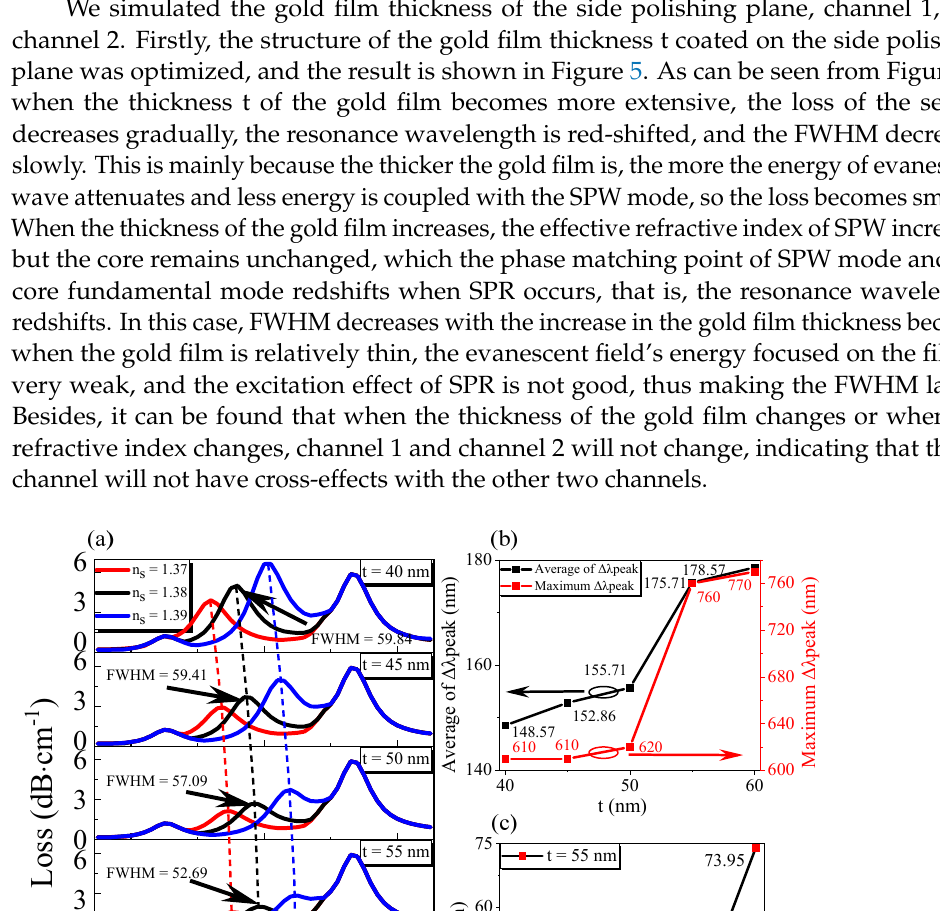
Figure 5. Optimization of metal film thickness t of plasmonic optical fiber sensor under the condition of the same T and H , and different refractive index of liquid to be measured: ( a ) The variation of transmission loss with wavelength; ( b ) The variation of resonance wavelength sensitivity of RI channel with gold film thickness t ; ( c ) The FWHM of RI channel varies with the refractive index of the external environment for t = 55